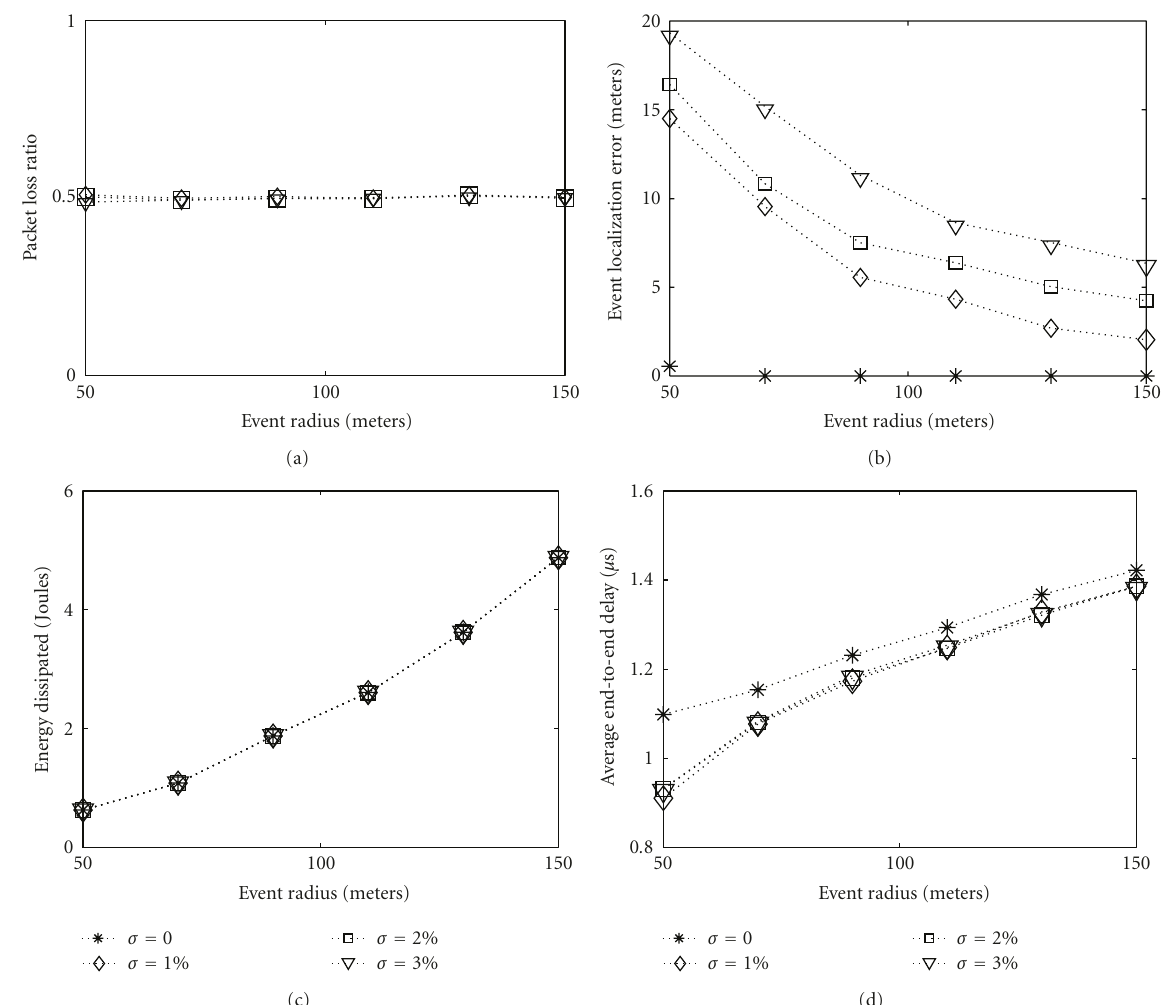
Figure 24: Sensitivity Analysis of Packet loss ratio, Event Localization error, Energy dissipation, and average End-to-end delay for Centralized data